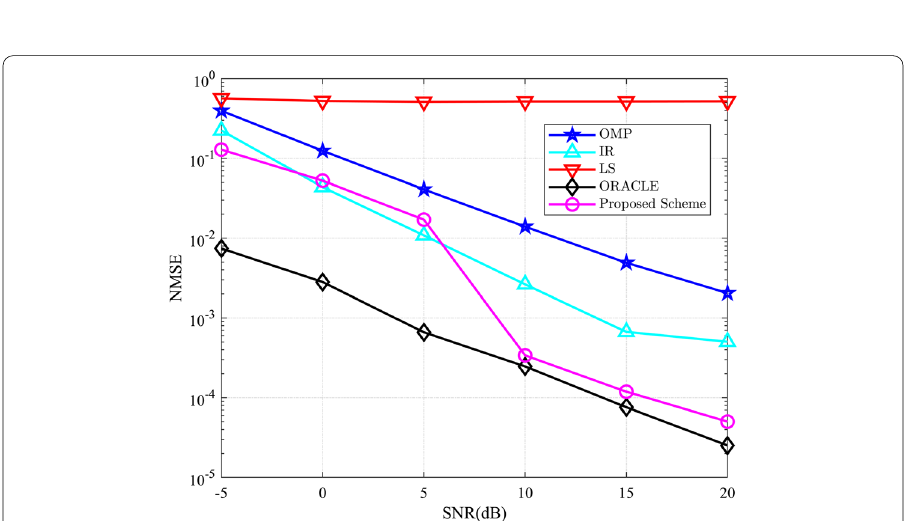
Fig. 5 NMSE performance comparison of different schemes against SNR, when N x = N y = 24 , N t = N r = 32 are considered,